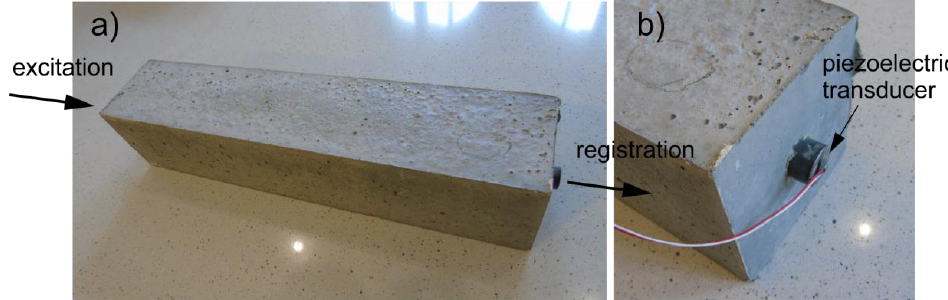
Figure 6. Experimental set up: ( a ) tested reinforced concrete beam and ( b ) a detail of transducer attached to rod embedded in beam.